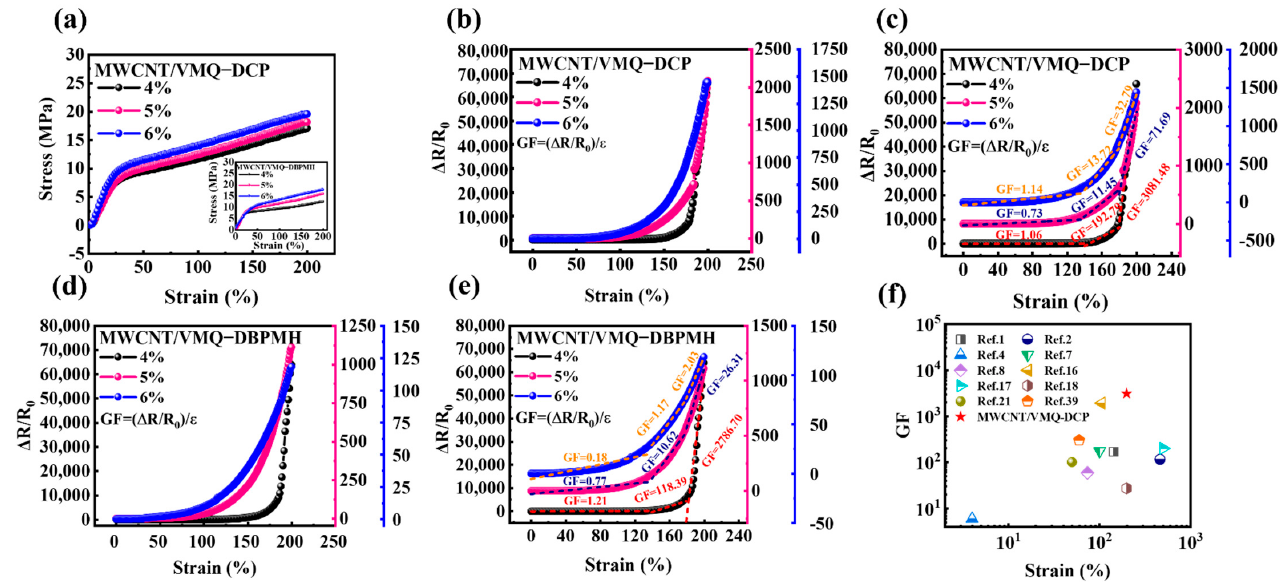
Figure 4. ( a ) Representative stress–strain curves of the two composites with various MWCNT contents. ( b ) The relationship between the strain and the resistance of the MWCNT/VMQ-DCP composite with different MWCNT contents. ( c ) The relationship between the sensitivity coefficient and the strain of the MWCNT/VMQ-DCP composites with different MWCNT contents. ( d ) The relationship between the strain and the resistance of the MWCNT/VMQ-DBPMH composite with different MWCNT contents. ( e ) The relationship between the sensitivity coefficient and the strain of the MWCNT/VMQ-DBPMH composites with different MWCNT contents. ( f ) The GF values and strain-sensing ranges of the MWCNT/VMQ-DCP